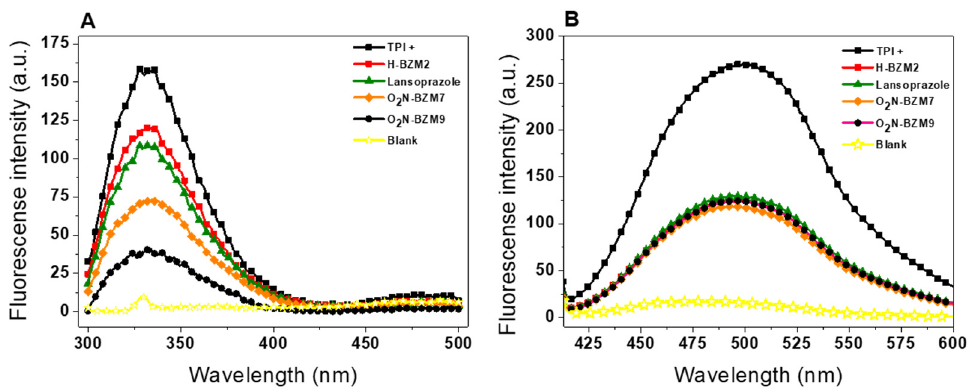
Figure 8. Fluorescence emission spectra of the TPI enzyme from G. lamblia . ( A ) Intrinsic fluorescence spectra of the TPI enzyme, and ( B ) 8-Anilinonaphthalene-1-sulphonate (ANS) assays in the absence or presence of the four synthesized compounds incubated at the IC 50 concentration. Values obtained from buffer containing ANS without protein (open stars) were subtracted from the recordings with protein. The experimental conditions for all the experiments are described in Section 3.6.1 of the Materials and Methods. The data are the mean of at least four independent experiments.